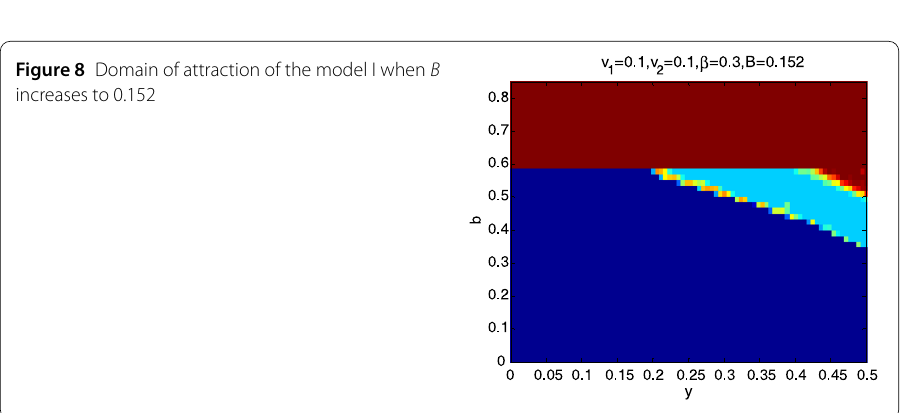
Figure 8 Domain of attraction of the model I when B increases to